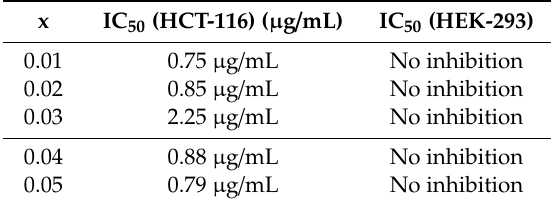
Table 1. Effect of Mn 0.5 Zn 0.5 SmEuFe 1.8 − 2x O 4 (0.01 ≤ x ≤ 0.05) NPs on cancerous cells human colon